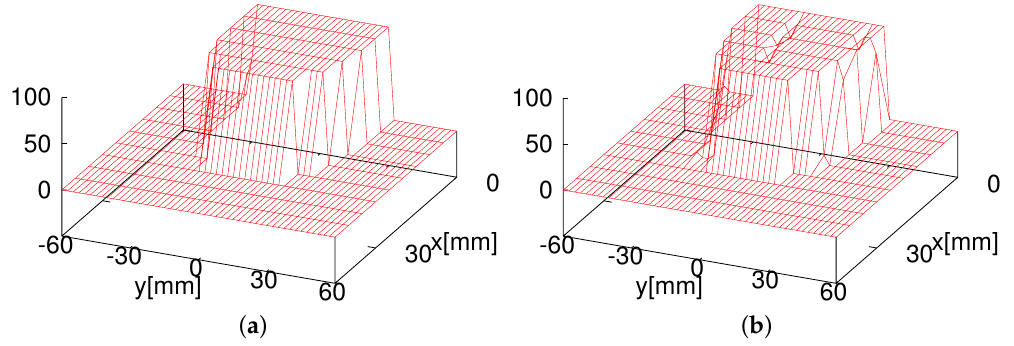
Figure 10. Tag detection rate at different heights (data provided by Art Finex Co., Ltd.). ( a ) 15 mm; ( b ) 20